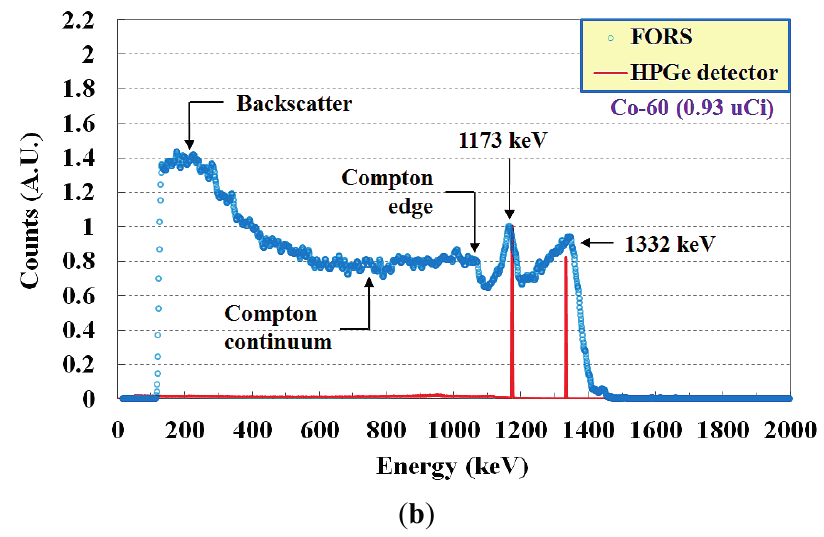
Figure 5. Calibrated gamma-ray energy spectra for ( a ) Cs-137 and ( b )